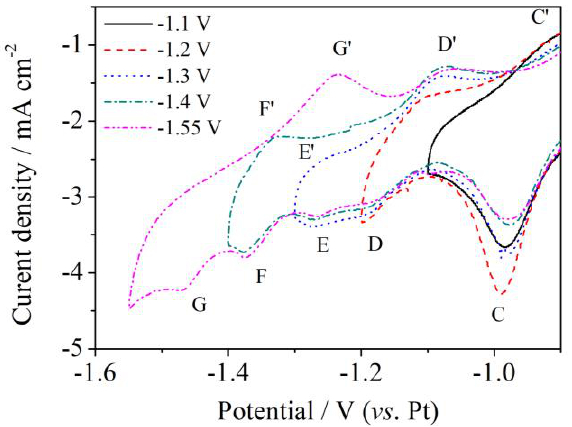
Figure 2. Cyclic voltammograms of a Ni wire electrode from LiCl-KCl-AlCl 3 (2 wt.%) melt at 753 K and different inversion potentials at scan rate of 0.03 V s −1 .